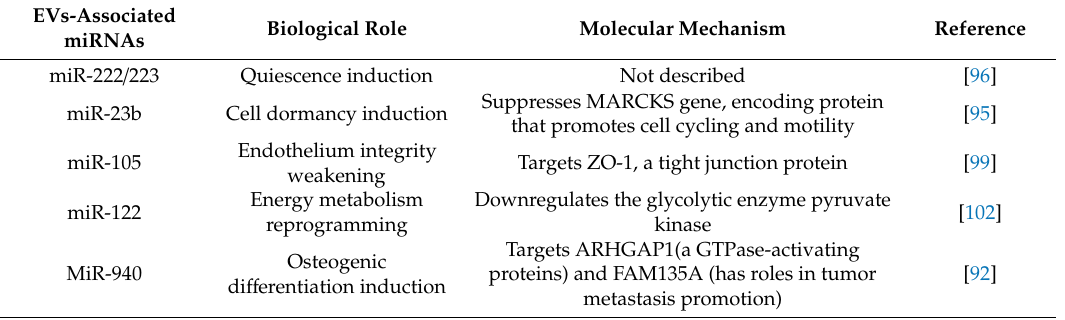
Table 1. EV-associated miRNAs for which a role in metastasis has been reported for